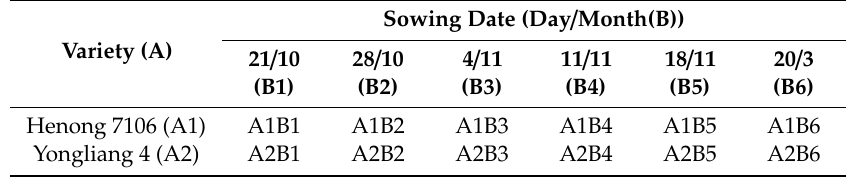
Table 4. Experimental design scheme for